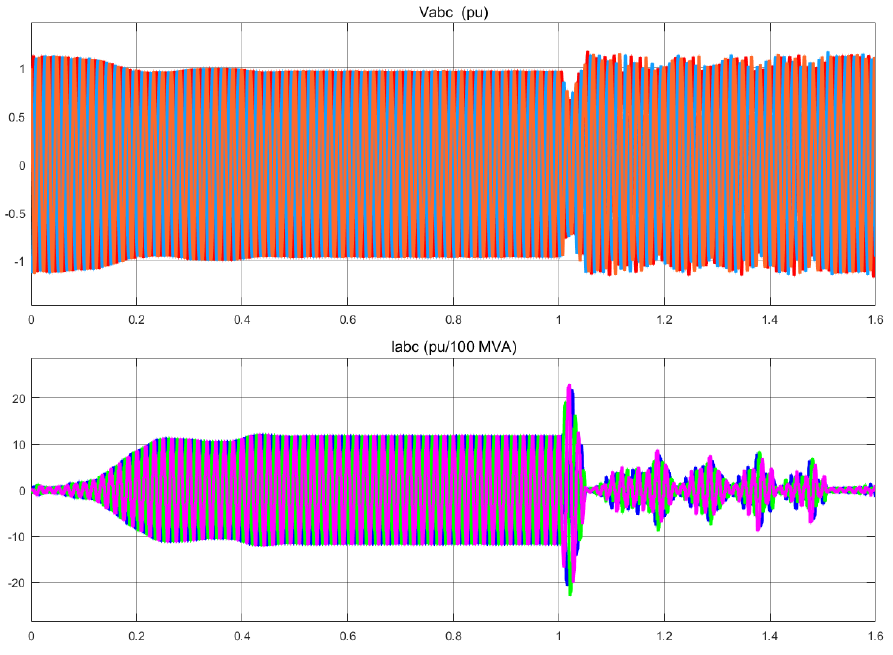
Figure 11. Three-phase voltage and current signals.